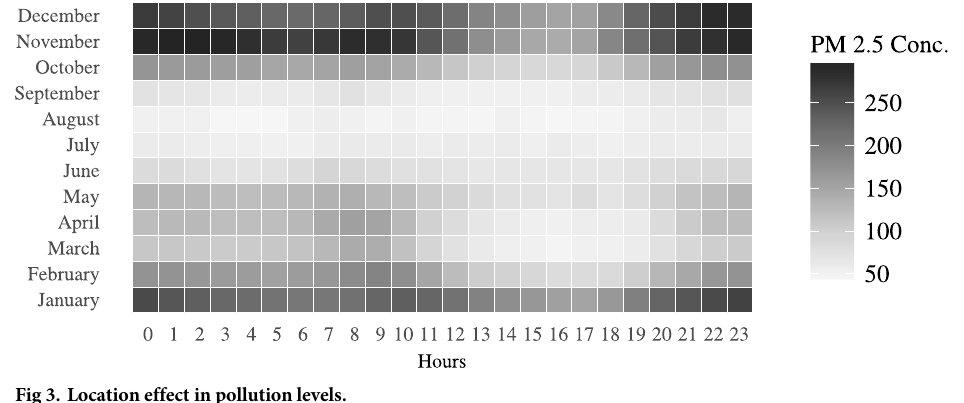
Fig 3. Location effect in pollution